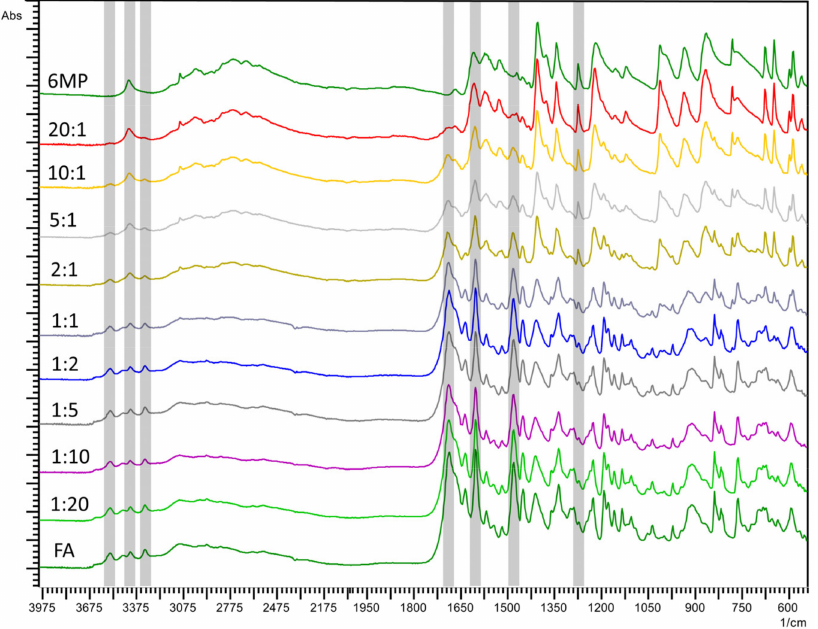
Figure 3. Fourier-transform infrared spectroscopy (FTIR) spectra of 6MP, FA and their physical blends. Numbers denote the 6MP:FA mass ratios in the blends. Greyed areas denote the characteristic bands referred to in the